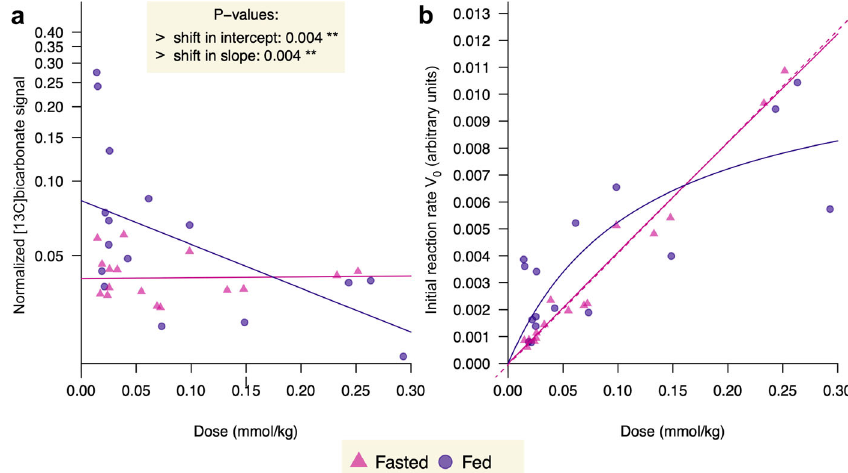
Fig. 2 Scatter plot of the HP [ 13 C]bicarbonate signal intensities normalized to the total sum of metabolites and corresponding initial reaction rate as a function of the injected dose of HP [1- 13 C]pyruvate. Points for 32 experiments (16 fed; 16 fasted) are coded by nutritional state (purple circles: fed; pink triangles: fasted). a The fi tted regression line of a heteroscedastic linear model is shown for each state. The p -values correspond to the two-sided Wald t-tests of equality of intercept and slopes. b The initial reaction rate V 0 (in arbitrary units) was obtained by multiplying the normalized HP [ 13 C]bicarbonate signal, which can be assumed to be proportional to an apparent pyruvate-to-bicarbonate conversion rate constant ( k pyr-bic ), with the corresponding substrate dose. The dotted line is a linear